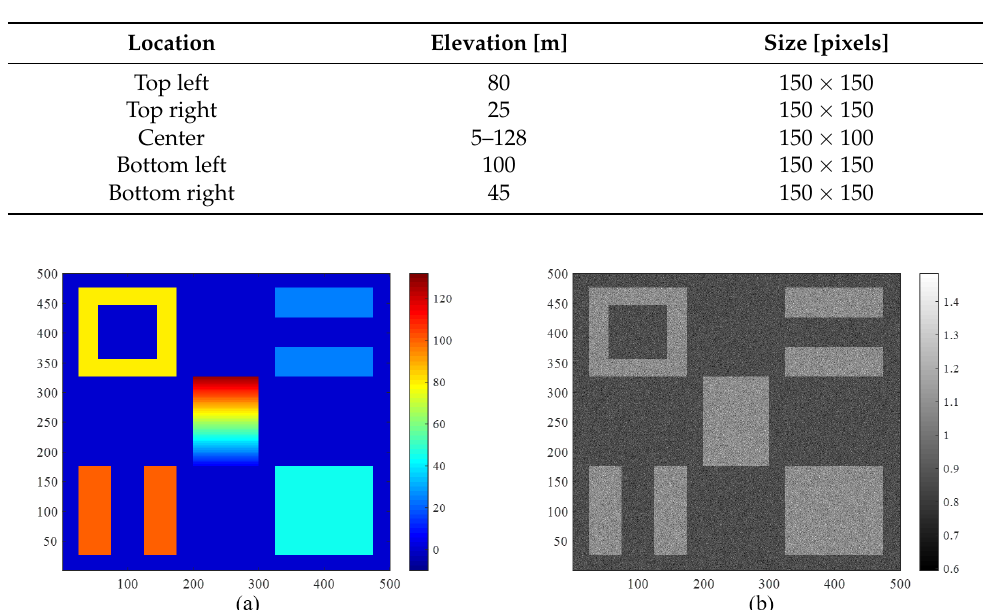
Table 1. The characteristics of simulated scene.